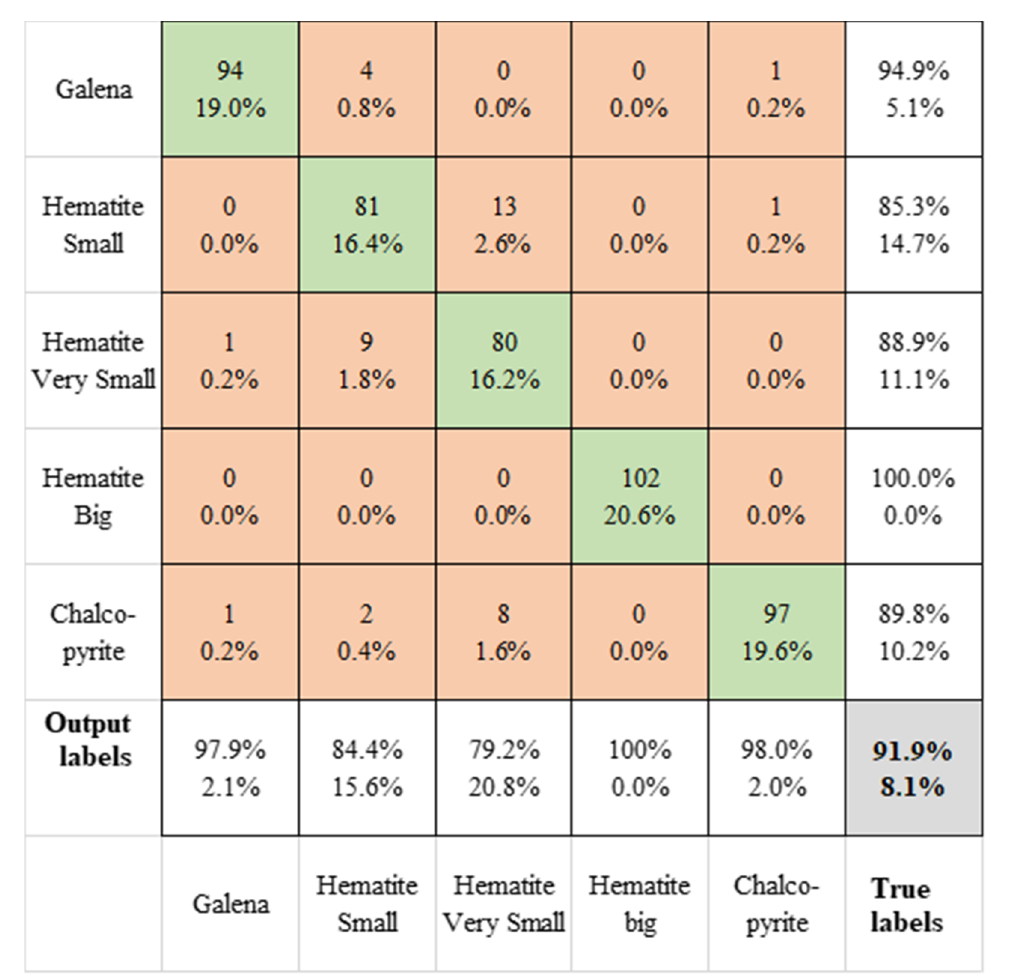
Figure 17. Confusion matrix of the deep learning results.